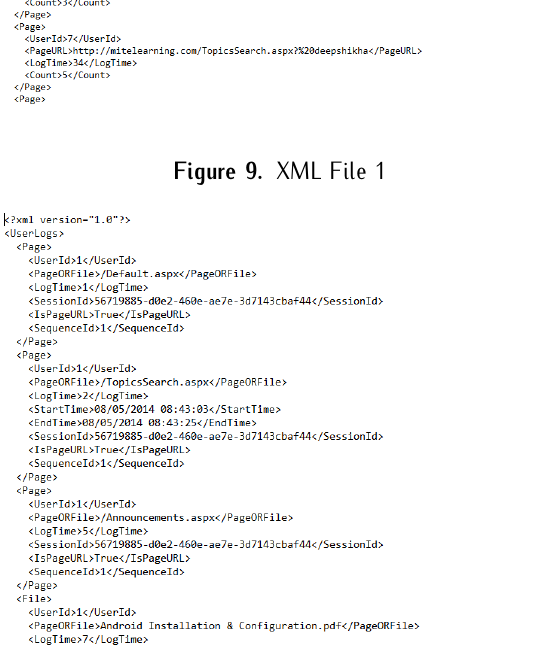
Figure 10. XML File 2